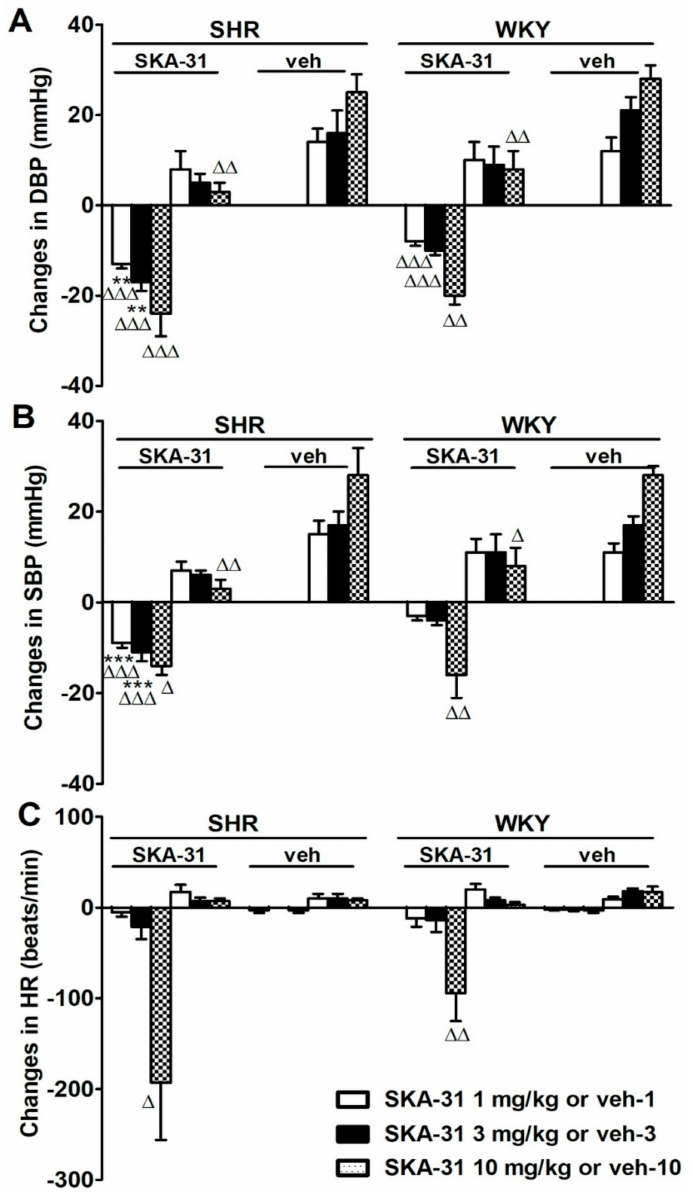
Figure 3. Influence of SKA-31 (1, 3, 10 mg / kg; i.v.) or vehicle on ( A ) diastolic blood pressure (DBP), ( B ) systolic blood pressure (SBP) and ( C ) heart rate (HR) of urethane-anaesthetized spontaneously hypertensive rats (SHR) and Wistar Kyoto rats (WKY). Mean ± SEM, n = 16, ** p < 0.01, *** p < 0.001 compared to respective WKY group; ∆ p < 0.05, ∆∆ p < 0.01, ∆∆∆ p < 0.001 compared to respective group receiving vehicle for